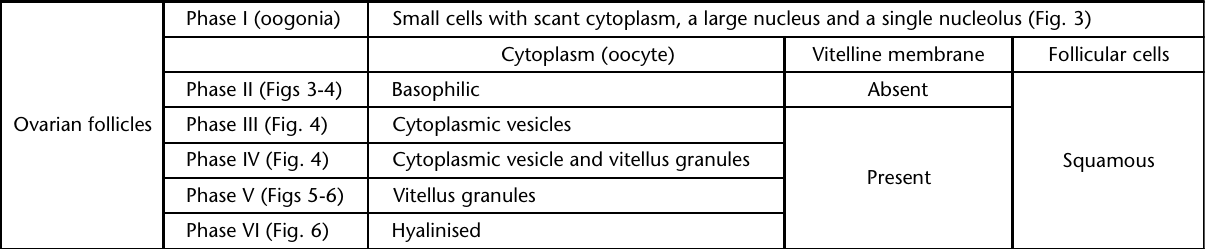
Table I. Description of the main features defining each phase of ovarian follicle development in A. lineatus in the Paranaguá Bay, state of Paraná.